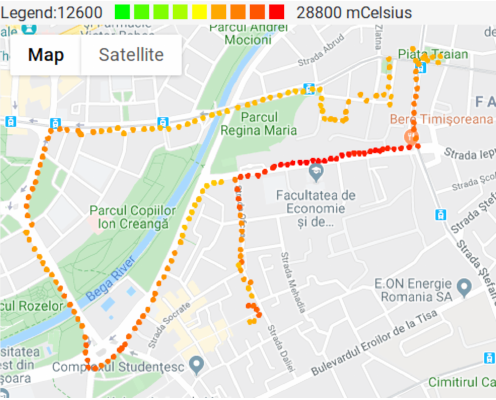
Figure 10. Temperature measurements.